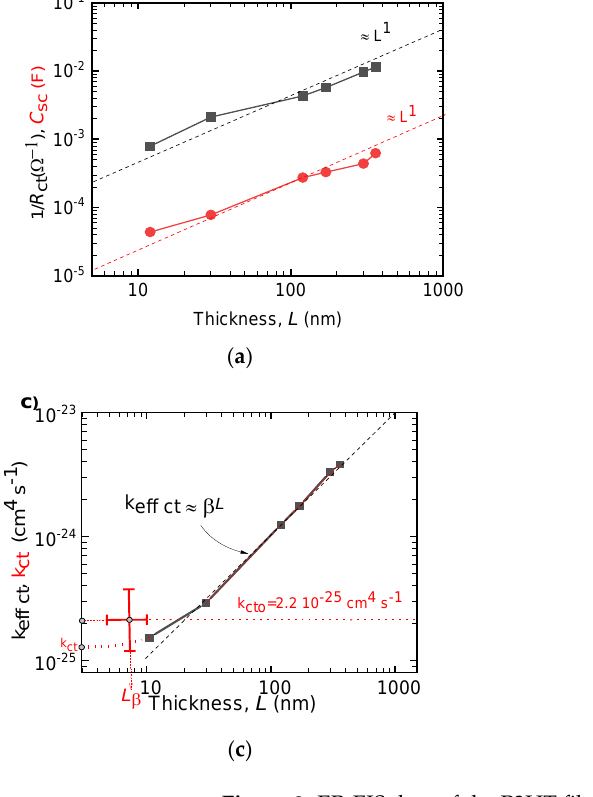
Figure 2. ER-EIS data of the P3HT films L ε(10;360)nm; ( a ) log vs log ( b ) lin vs lin, The rough unprocessed ER-EIS 0.1/ R ct and C sc data for HOMO top ( U = − 1 V, E = − 5.5 eV) vs the thickness L ; ( b )the fitting the linear part gave β = 0.038 ± 0.002 nm −1 (and L β = 26 ± 2 nm) and k ct = 4.3 × 10 −2 5 cm 4 s −1 ; ( c ) The effective rate constant k eff ct = k ct (1 + β L ) (black) of the overall D-A rate vs sample thickness L , also denoted is the extrapolation fitting for the poreless P3HT rate constant k ct = 1.3 × 10 −25 cm 4 s −1 (red dotted curve) and slope fitting k ct o = (2.2 ± 0.6)10 −25 cm 4 ·s −1 ; ( d ) The DOS function gained using Equation (3) from the ER-EIS data (Figure S2b), g sc (for U = − 1 V, E = − 5.5 eV) vs film thickness L with the average value g sc = 5.6 × 10 20 cm − 3 eV −1 .